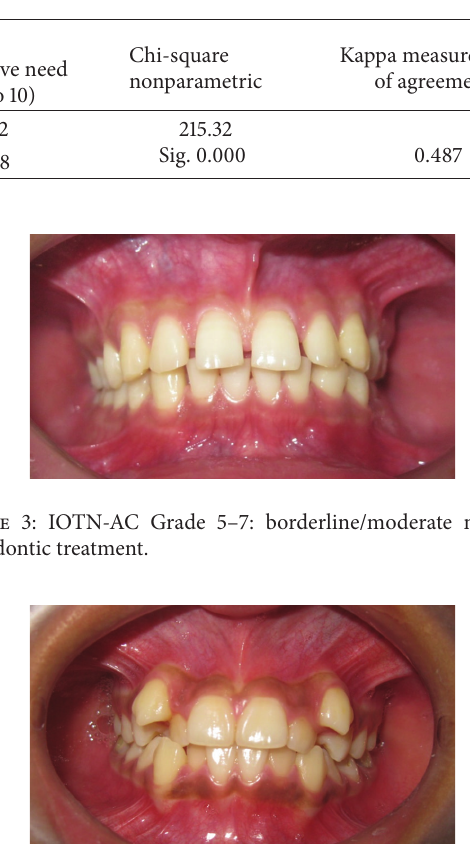
Table 2: Comparison of subject’s perception and orthodontist’s assessment of IOTN-AC.